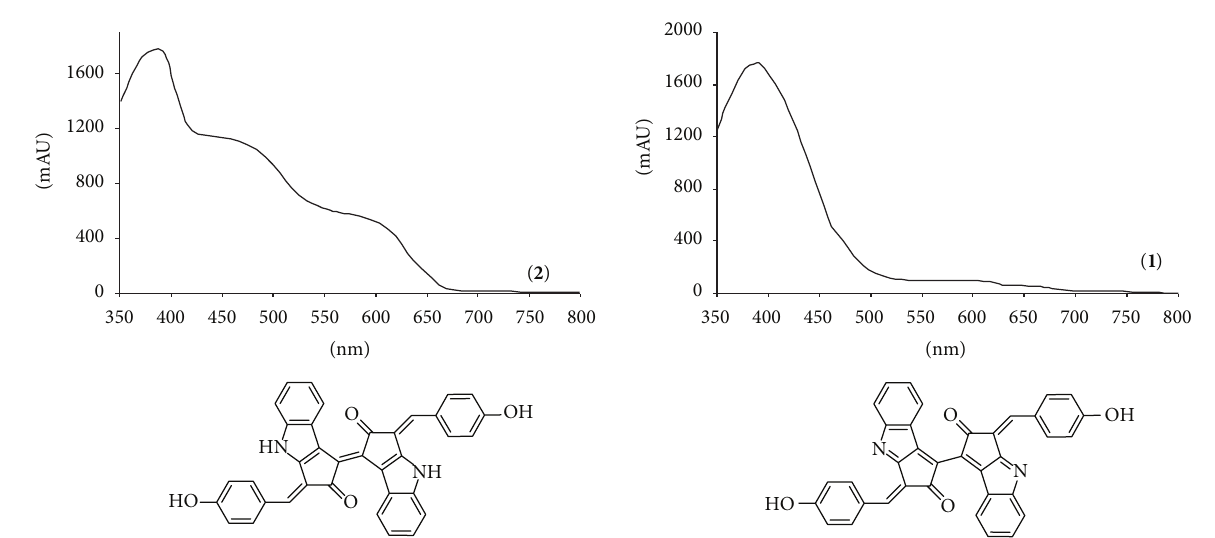
Figure 4: UV-vis spectra and formulae of scytonemin ( 2 ) and its reduced form ( 1 ).